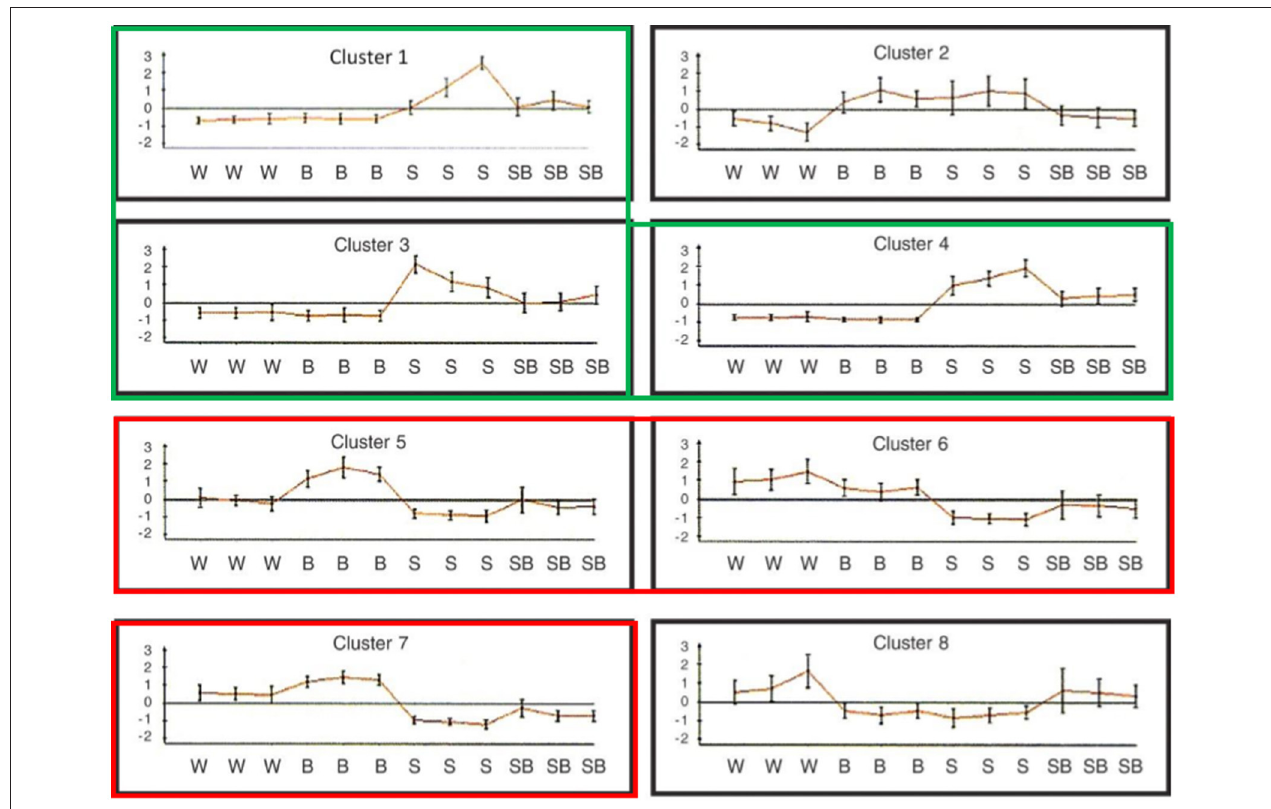
FIGURE 5 | Graphic representation of the expression patterns of gene clusters under salinity stress with and without adding CK. Genes were divided into 8 clusters according to the expression pattern. Each graph presents one cluster with 12 samples: 4 treatments (W, water; B, 10 µ m BAP; S, 120mM NaCl; SB, NaCl plus BAP) in three biological replicates for each treatment. Gene clusters: cluster 1 contained 710 probes; cluster 2, 32 probes; cluster 3, 487 probes; cluster 4, 1405 probes; cluster 5, 342 probes; cluster 6, 553 probes; cluster 7, 1517 probes; and cluster 8, 38 probes. The red (clusters 1,3,4) and green (clusters 5,6,7) colors represent gene clusters displaying similar